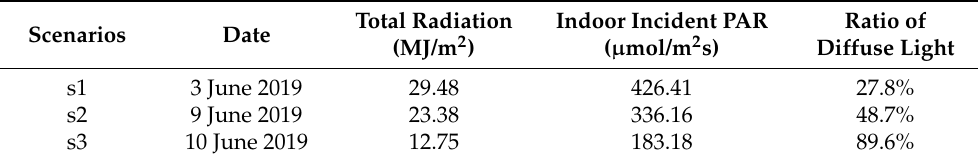
Table 1. The scenario setting for the simulation of light interception.